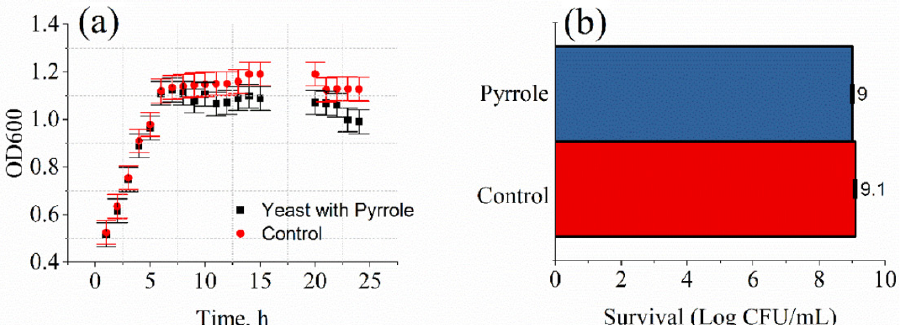
Figure 1. The viability of Saccharomyces cerev isiae yeast cells under the action of 0.3 M pyrrole solu- tion: ( a ) Growth curves of Saccharomyces cerevisiae yeast cells:Control—yeast cells without pyrrole; yeast cells with 0.3 M pyrrole. ( b ) Effect of pyrrole solution on the formation of yeast cell colonies. The data are given as log CFU/mL survival.